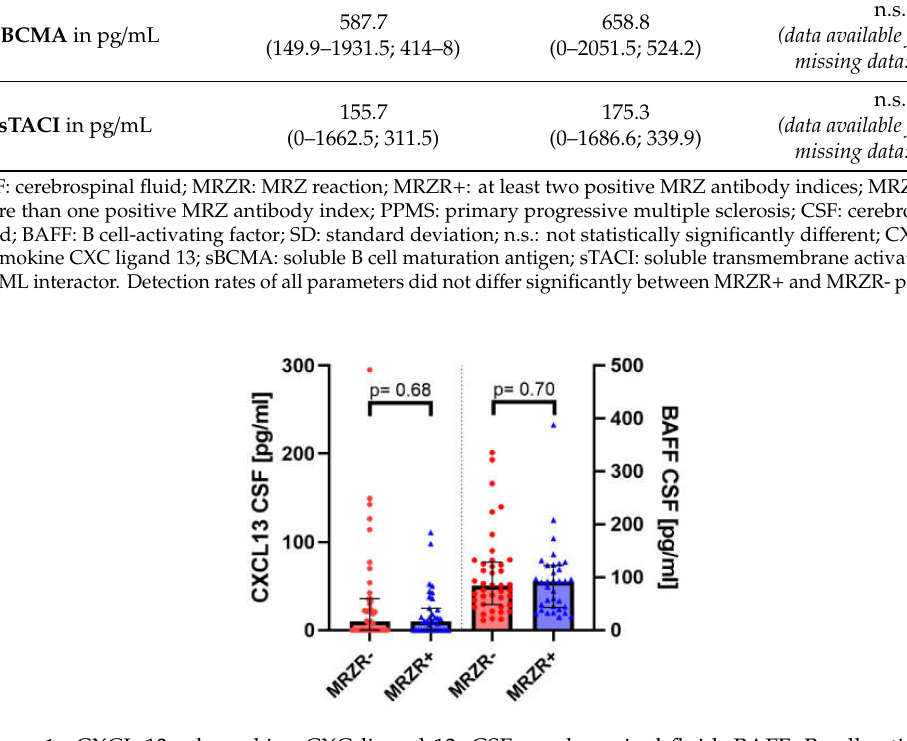
Figure 1. CXCL-13: chemokine CXC ligand 13; CSF: cerebrospinal fluid; BAFF: B cell-activating factor; MRZR-: primary progressive multiple sclerosis patients with no more than one positive MRZ antibody index; MRZR + : primary progressive multiple sclerosis patients with at least two positive MRZ antibody indices.